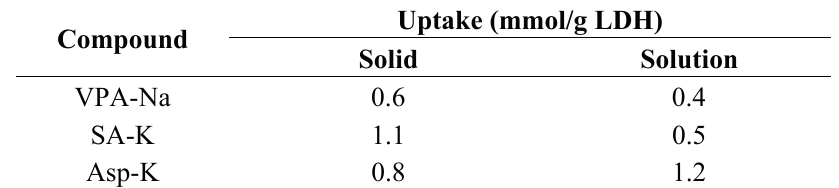
Table 3. Uptake of VPA-Na, SA-K, and Asp-K in LDH(Cl) in solid-state reaction and in